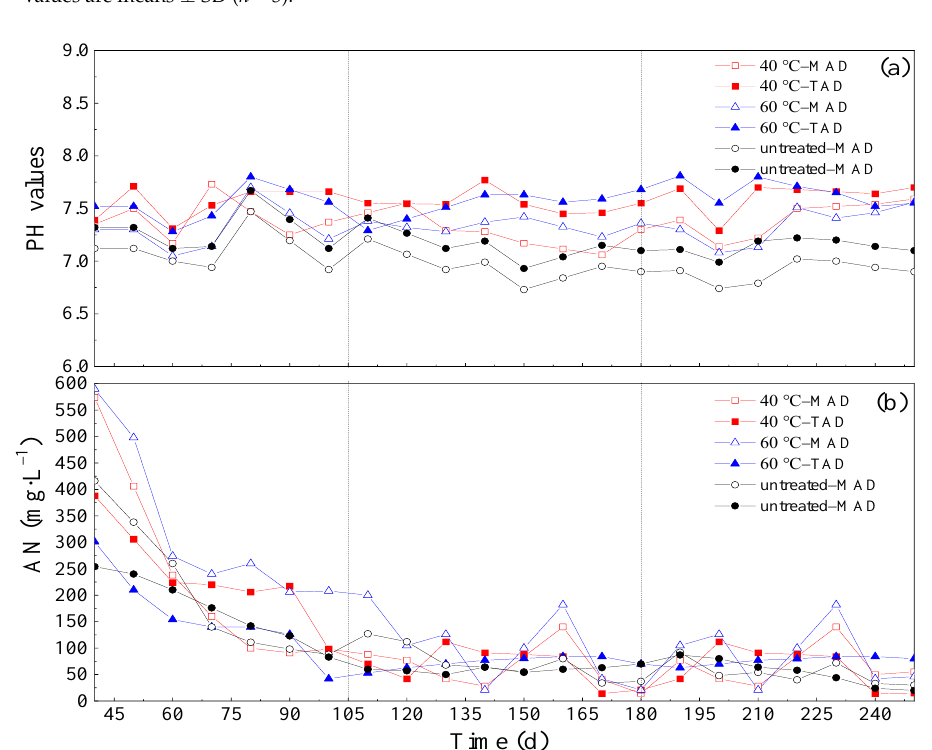
Figure 4. ( a , b ). The pH values and AN concentration of different pretreatment and anaerobic digestion temperatures. ( a ): pH; ( b ): AN.